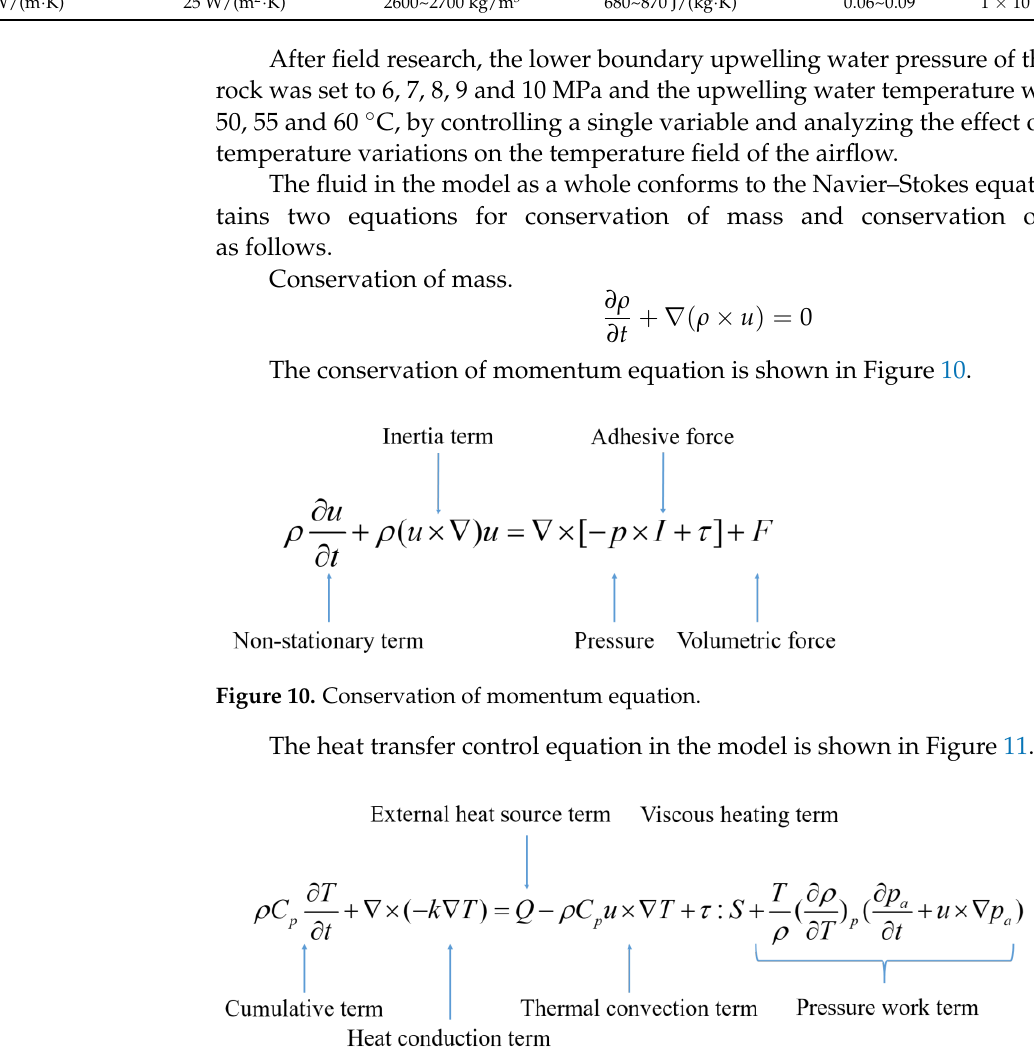
Figure 11. Heat transfer control equation.